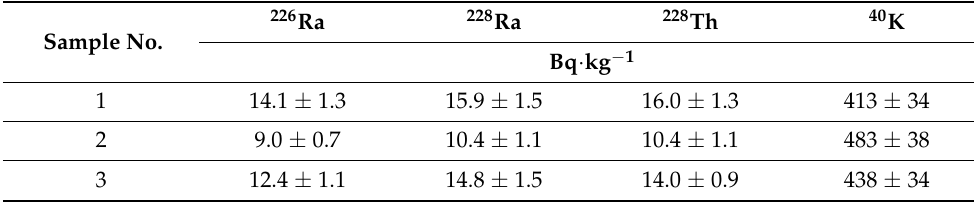
Table 2. The concentration of radionuclides in rocks. 226 Ra 228 Ra 228 Sample No.